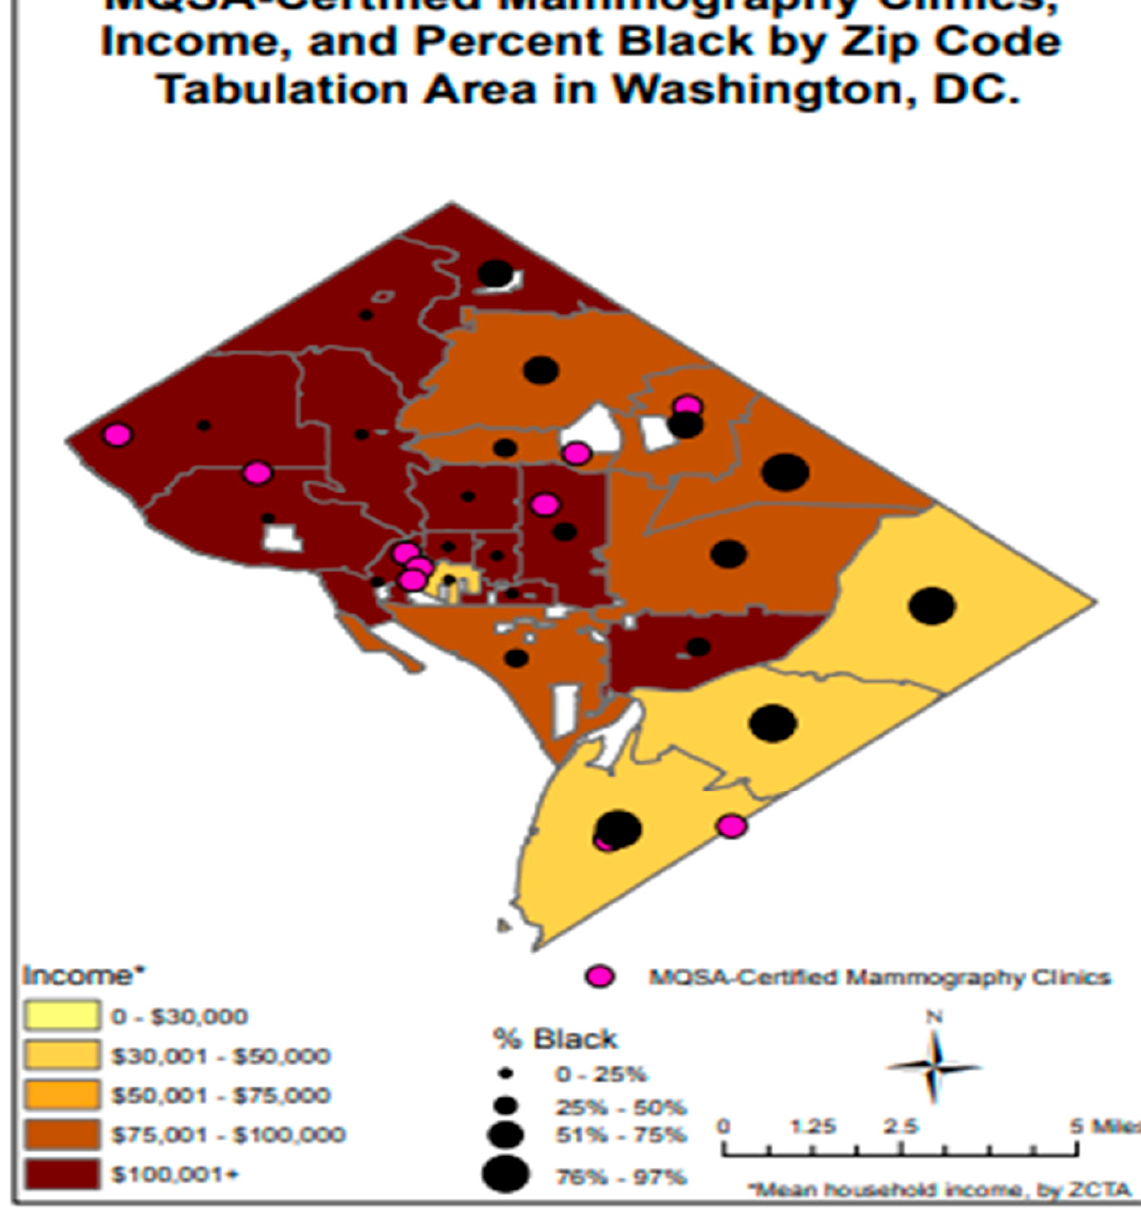
Figure A7. MQSA-Certified Mammography Clinics, Income, and Percent Black by ZIP Code Tabula- tion Area in Washington, DC.